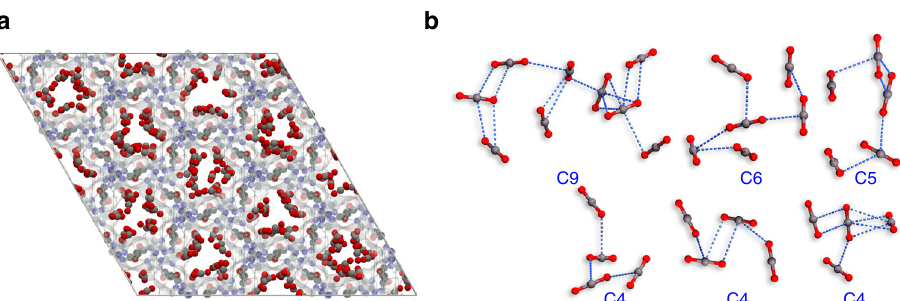
Fig. 5 The snapshot for CO 2 -loaded FJI-H14. a The snapshot of CO 2 adsorption for FJI-H14 at 11.2 kPa and 273.15 K calculated using the GCMC method. b The representative CO 2 clusters including nine (C9), six (C6), fi ve (C5) and four (C4) CO 2 molecules. The blue dashed line represents weak interactions between neighboring CO 2 molecules with a short C ··· O separation (from 2.71 to 3.50 Å) for adjacent CO 2 molecules